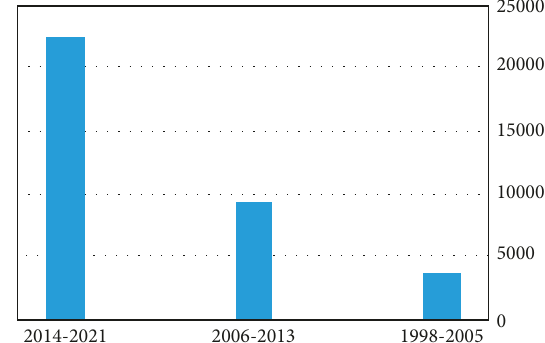
Figure 2: The number of articles and research on green roofs every seven years from 1998.